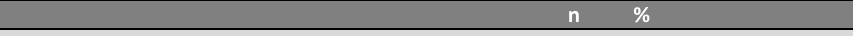
Figure 2. Recency of visit to veterinarian, expectations of therapy and satisfaction with treatment decision.